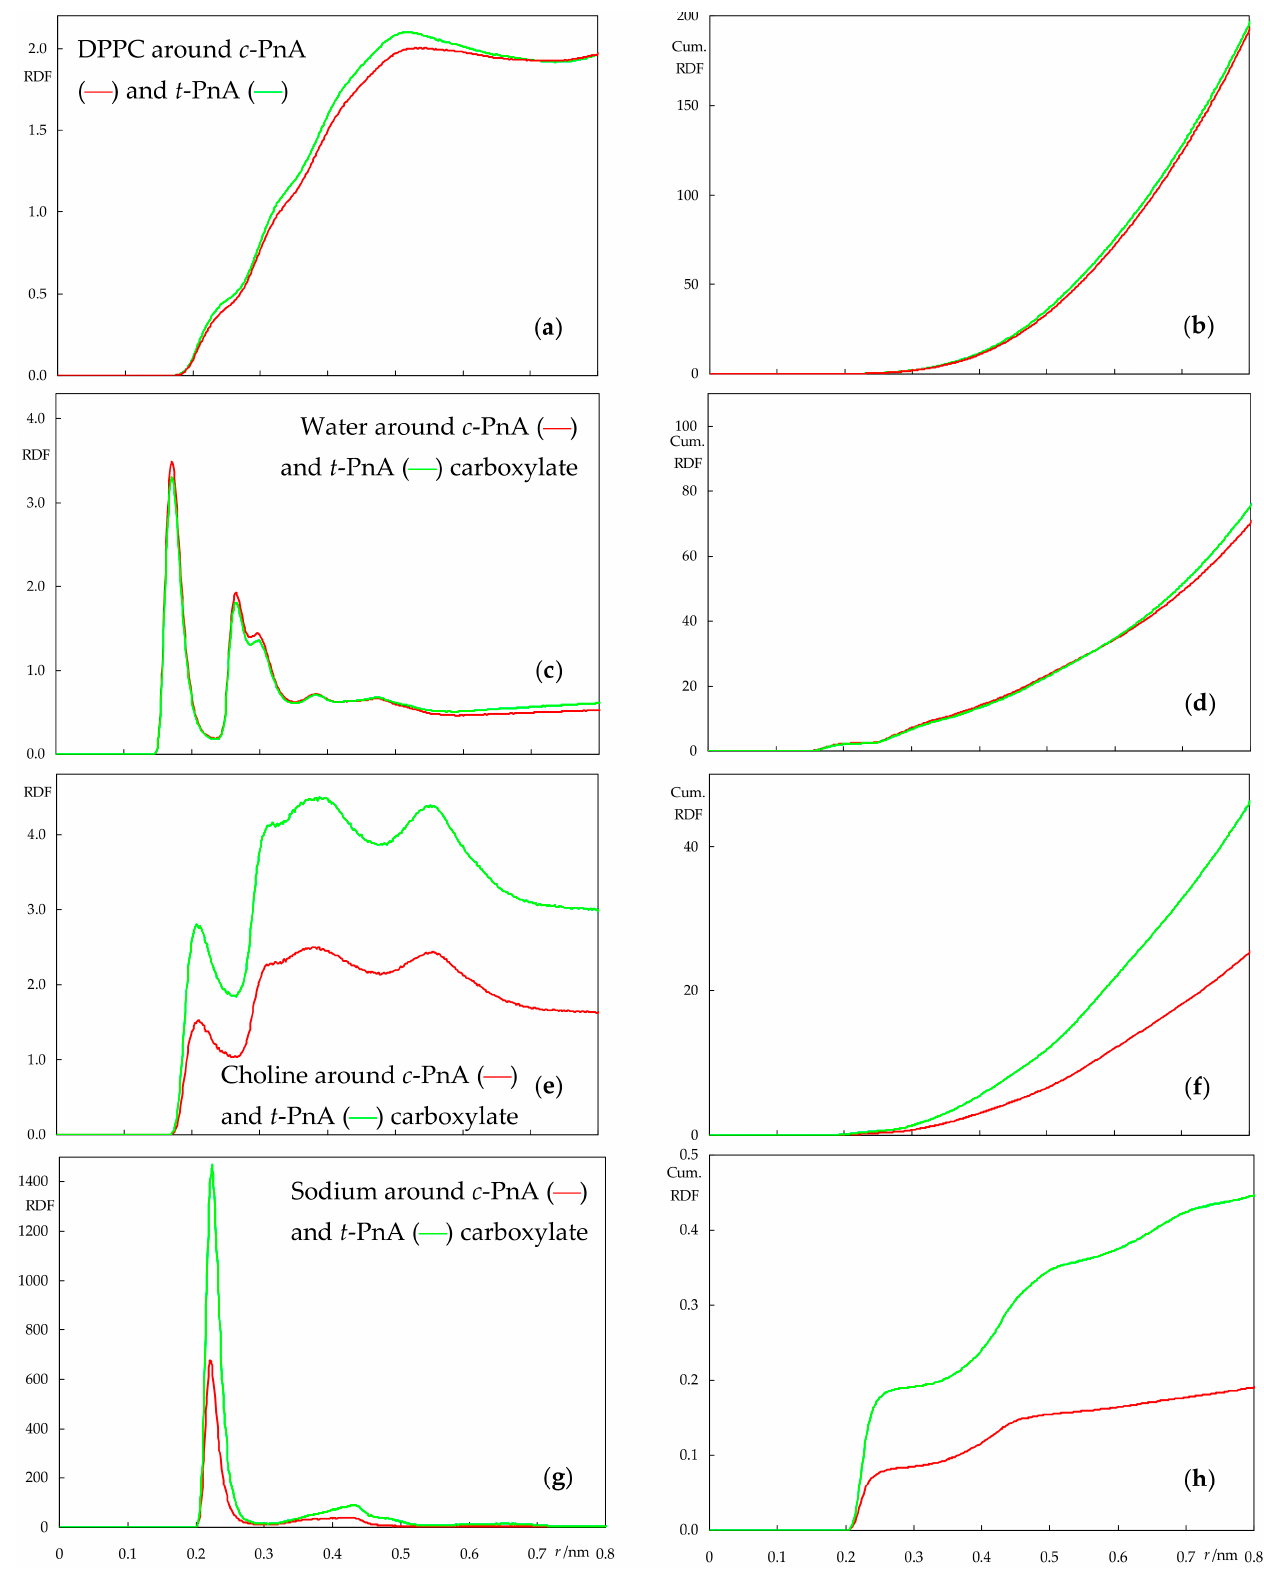
Figure 9. Atom–atom radial distribution density functions (RDFs, left plots) and their cumulative counterparts (cumulative RDFs, right plots) of lipid around PnA ( a , b ) and water ( c , d ), lipid choline ( e , f ) and sodium ion ( g , h ) around PnA carboxylate, calculated for the DPPC simulations. Red and green curves refer to simulations with c ‐ PnA and t ‐ PnA, respectively.